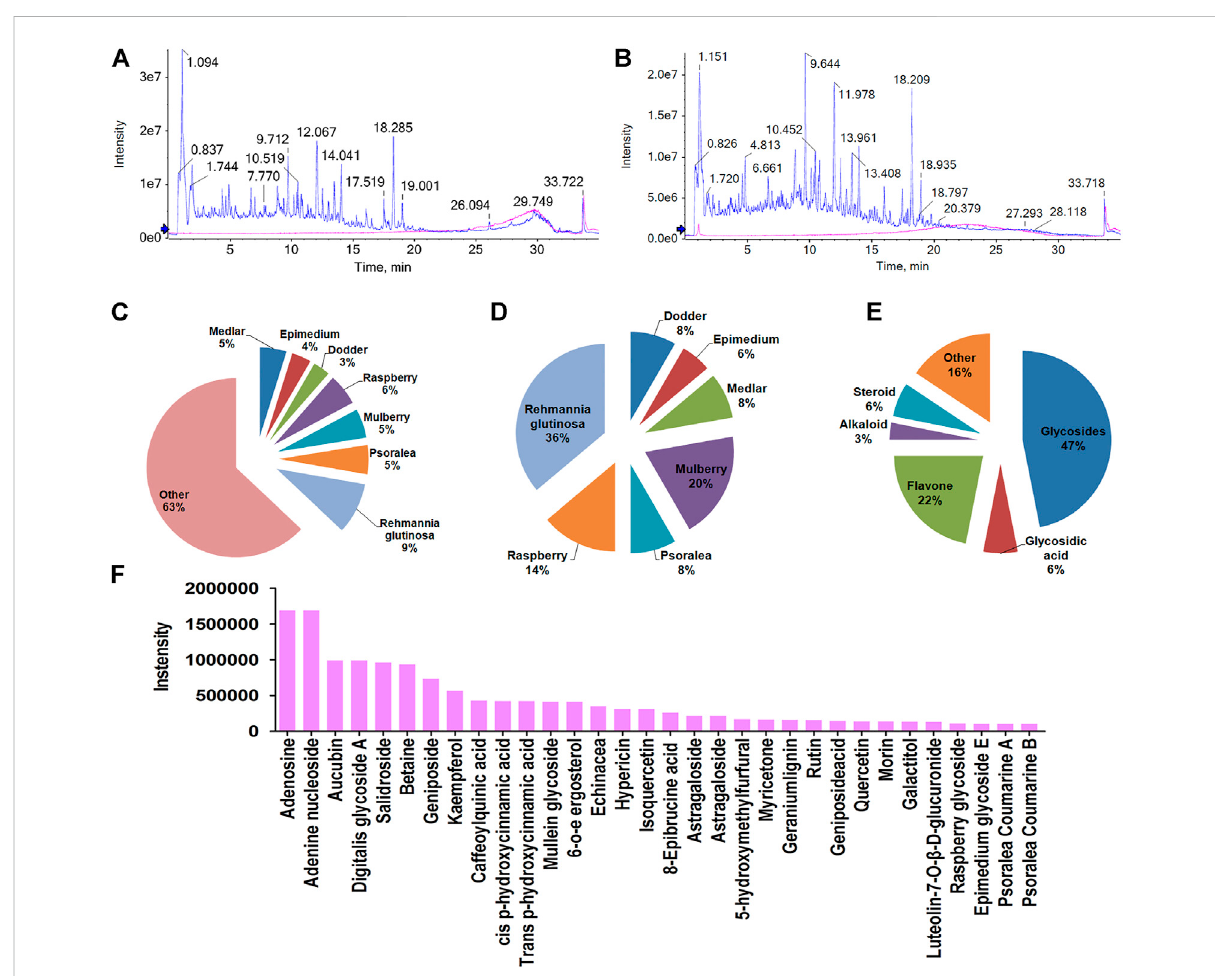
FIGURE 4 Chemical composition of CHMACS. HPLC/MS spectra of CHMACS in the (A) positive and (B) negative ion modes. (C) Distribution of chemical components of CHMACS and (D) of those with intensity > 100,000. These active components were mainly derived from R. glutinosa , mulberry, raspberry, Psoralea , and other CHMs. (E) Classi fi cation of the active components of CHMACS based on their chemical properties. (F) Chemical components of CHMACS according to their